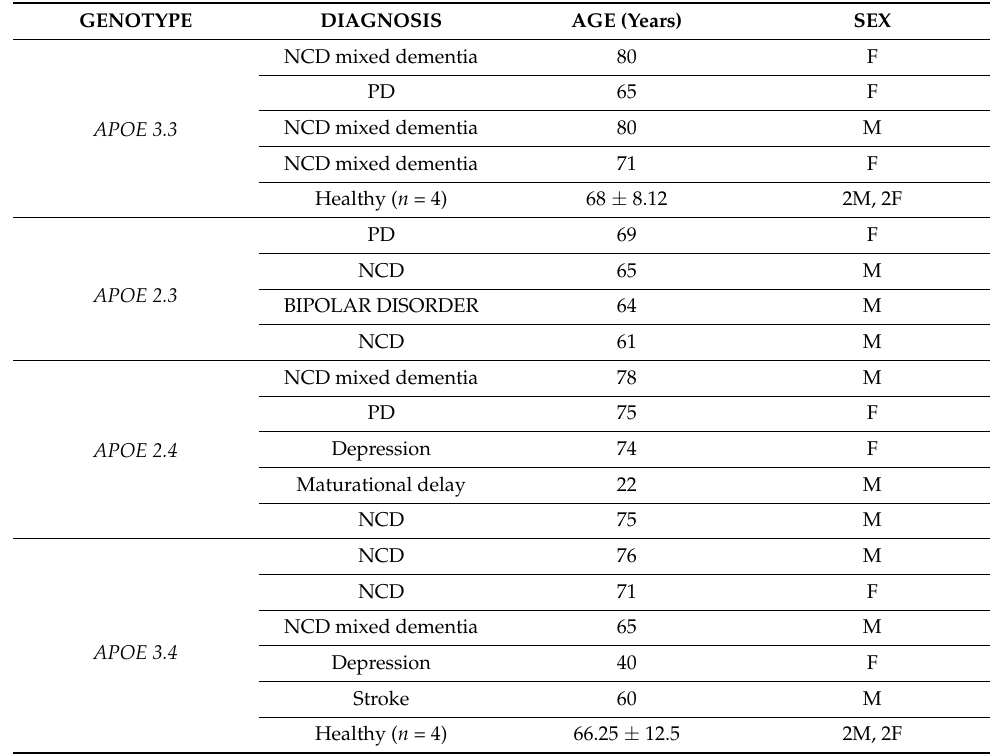
Table 2. Demographics and diagnosis of patients with different APOE